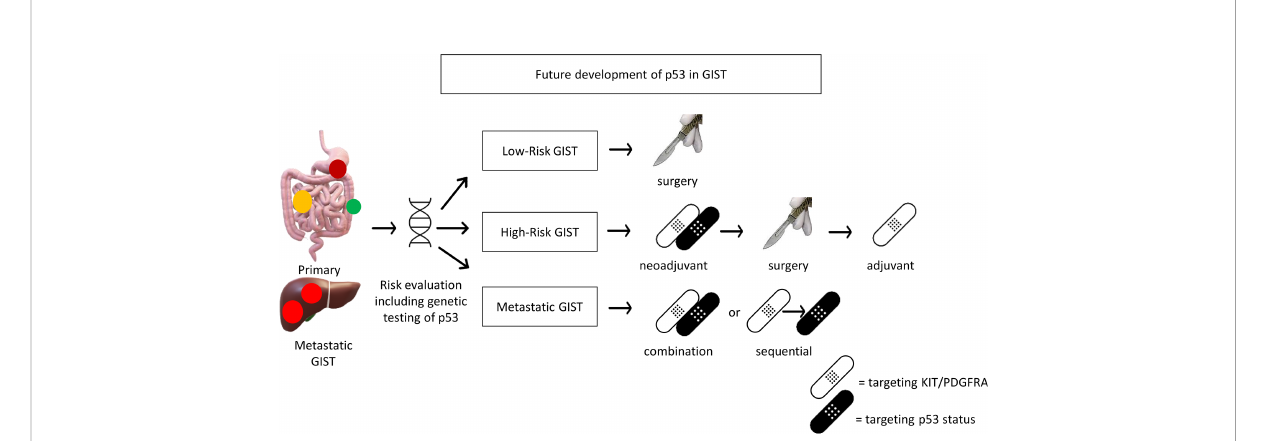
FIGURE 1 Future development of p53 for potential clinical application in GIST. Genetic testing including p53 should be included for risk evaluation. p53 targeted therapy (MDM2 inhibitor for wild-type p53 or Wee1 inhibitor for mutant p53) may be incorporated in palliative treatment for metastatic GIST or neoadjuvant treatment for high-risk GIST (if it works in metastatic